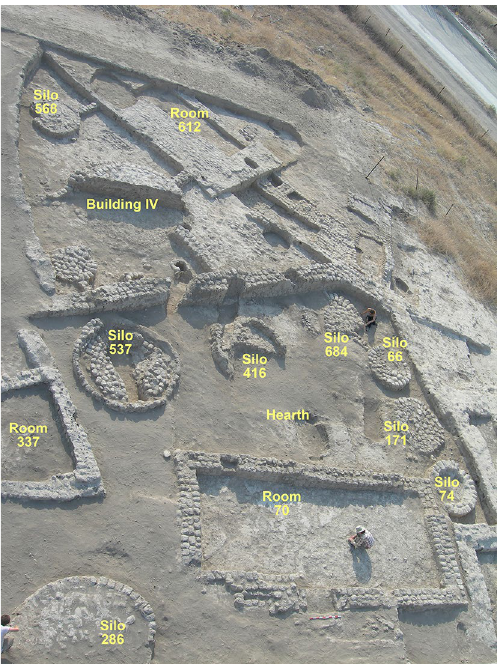
Figure 3. The village of Tel Tsaf; an overview of Area C with courtyard buildings, comprising rectangular and rounded rooms and rounded silos (Photo by Y.